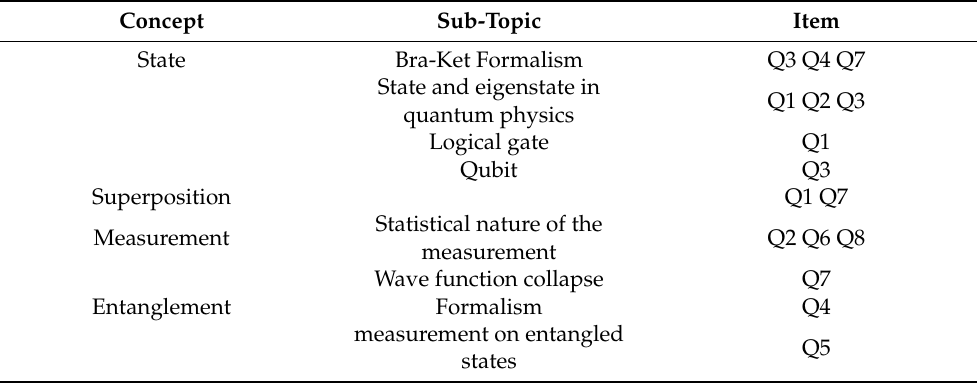
Table 1. The main topics addressed in the quantum technologies inventory